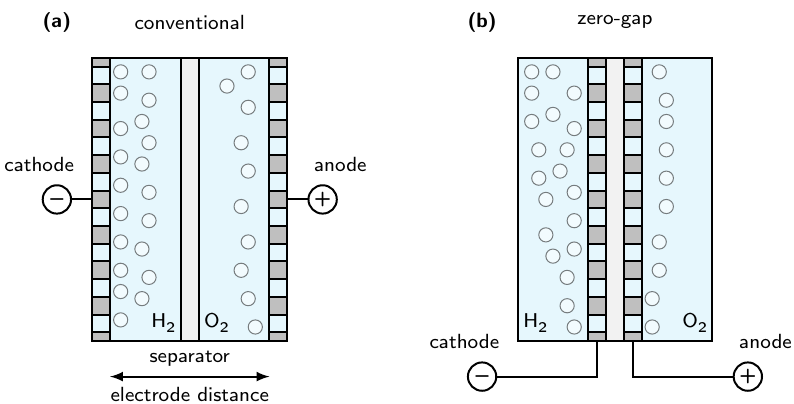
Figure 3. Different cell designs for alkaline water electrolysis. Whereas ( a ) shows a conventional assembly with a defined distance between both electrodes, ( b ) depicts a zero-gap assembly where the electrodes are directly pressed onto the separator [38].